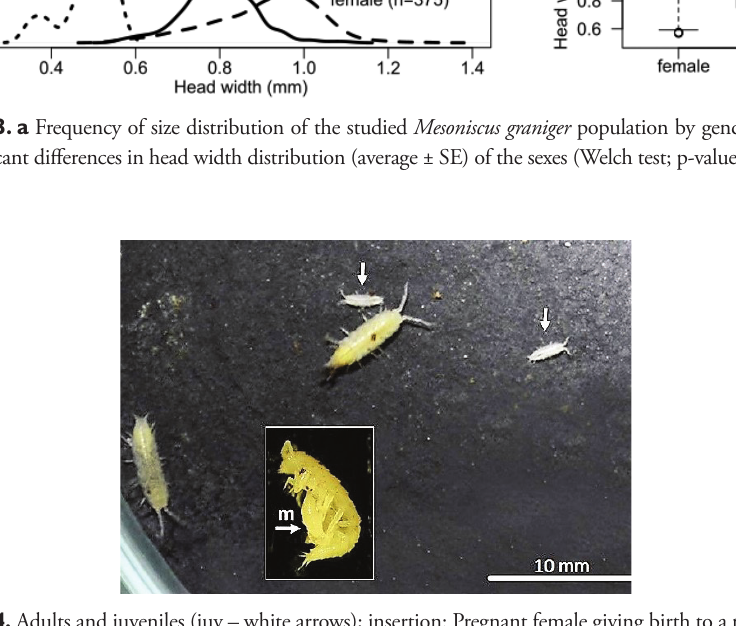
Figure 4. Adults and juveniles (juv – white arrows); insertion: Pregnant female giving birth to a manca